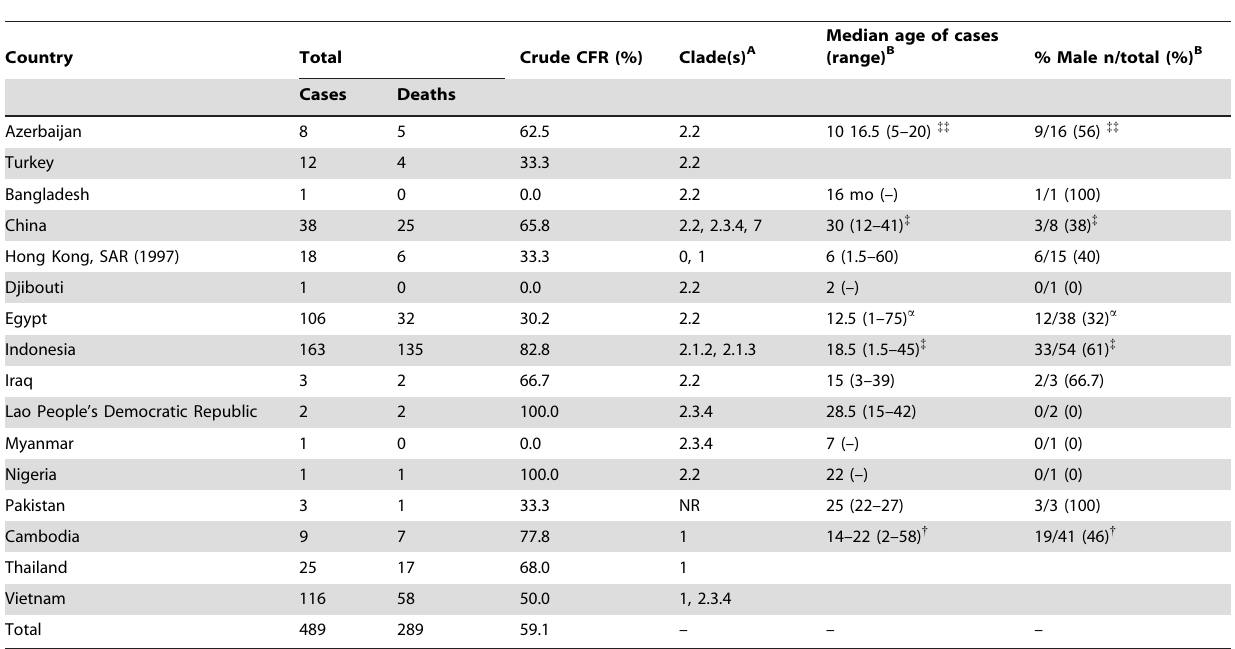
A Clade(s) isolated from humans. B Data from cases up to 1 Jan 2009.